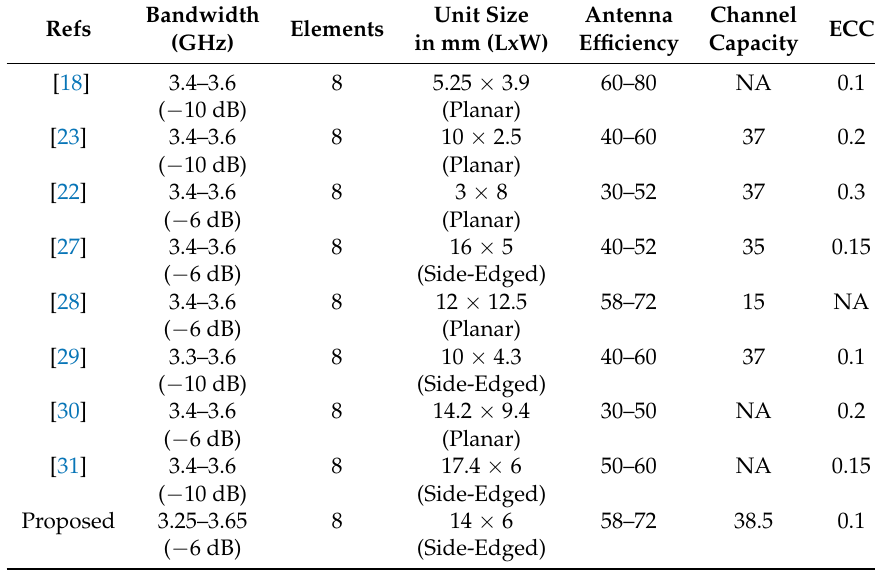
Table 3. Comparison of the proposed MIMO antenna design with other designs known from the